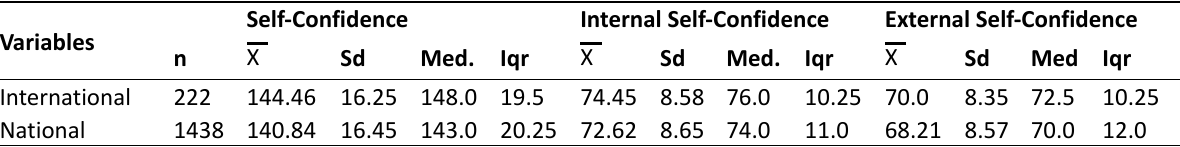
Table 4. Comparison of self-confidence and sub-dimensions according to athletes’ sport level